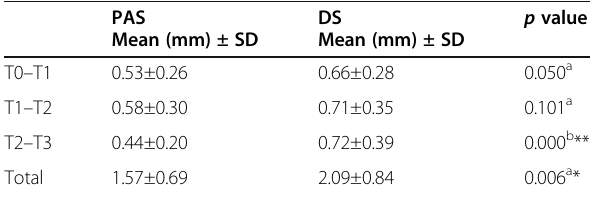
Table 3 A comparison of monthly retraction rates of the two techniques